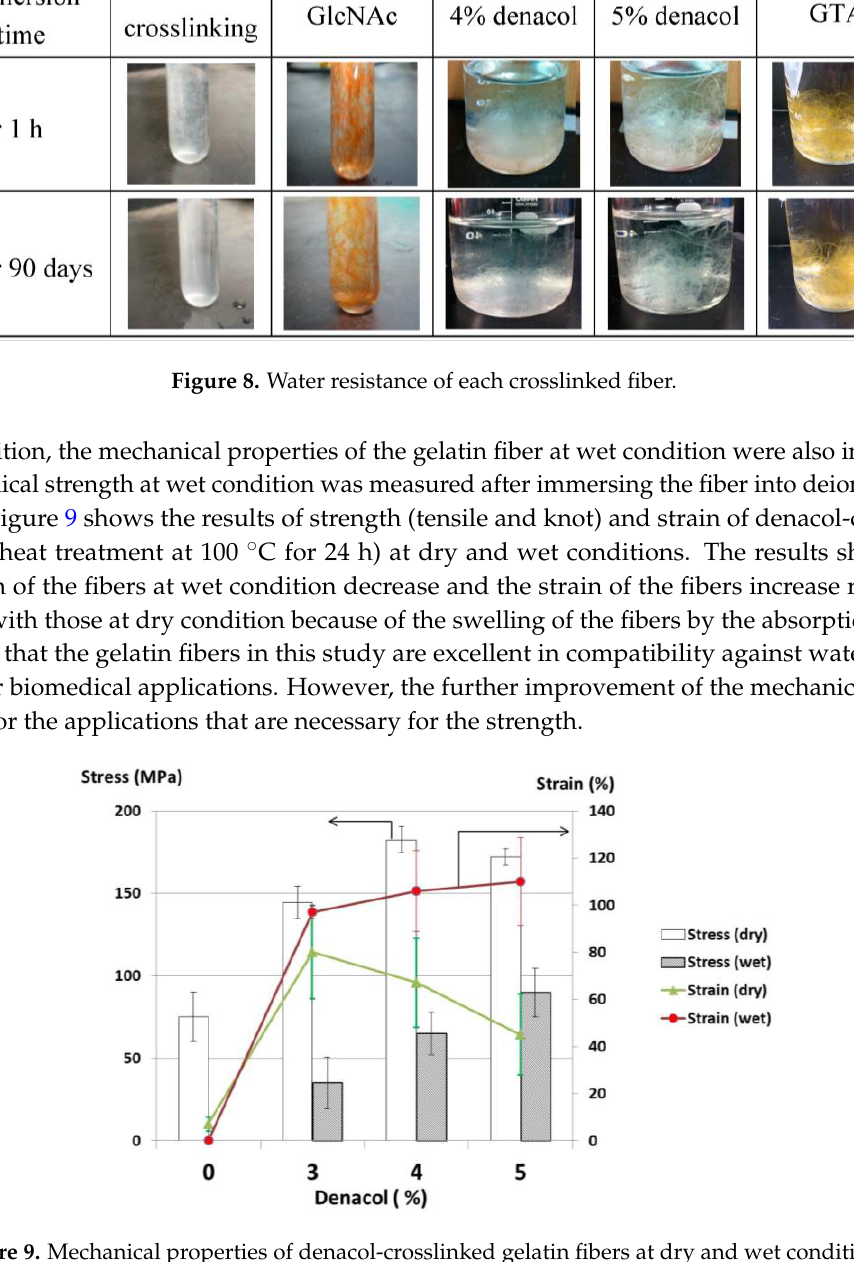
Figure 9. Mechanical properties of denacol-crosslinked gelatin fibers at dry and wet conditions.